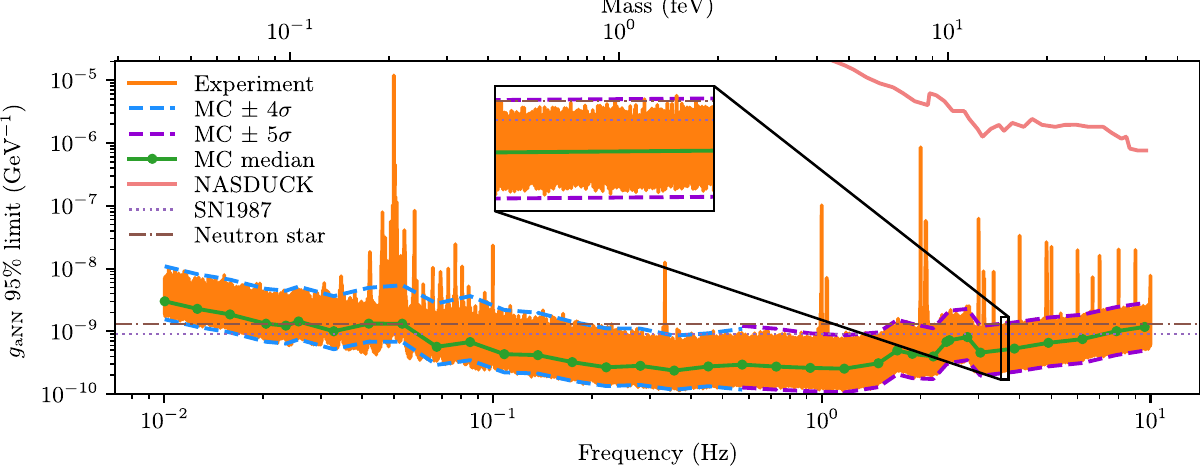
FIG. 5. Orange lines show the 95% upper limit on g obtained from our experimental data. The sensitivity of the experiment can be aNN characterized by recovering the 95% upper limit over an ensemble of Monte Carlo data with no injected signal and plotting the median of those recovered limits (shown as green dots with connecting line to guide the eye). We achieve a median limit of 2 . 4 × 10 − 10 GeV − 1 at 0.36 Hz, approximately 5 orders of magnitude stronger than previous laboratory bounds. Because of the large number of axion masses tested, there is a considerable spread in the recovered limits. This is, however, consistent with the (cid:3) 4 σ and 5 σ bands (illustrated by pairs of dashed blue and violet lines, respectively) obtained via Monte Carlo simulations. At higher axion frequencies, there is a greater density of axion masses on the log-scale plot, but as the magnifying inset shows, the recovered experimental limits are within the (cid:3) 5 σ band as expected when viewed at the appropriate scale. The dotted SN1987 limit is a constraint from Ref. [58], which refines the usual one-pion-exchange approximation of the nucleon-nucleon bremsstrahlung process. The dash-dot neutron star limit is a 95% upper limit from Ref. [59] that analyzed cooling from five neutron stars. Limits from the NASDUCK Collaboration [28] are shown as a coral solid